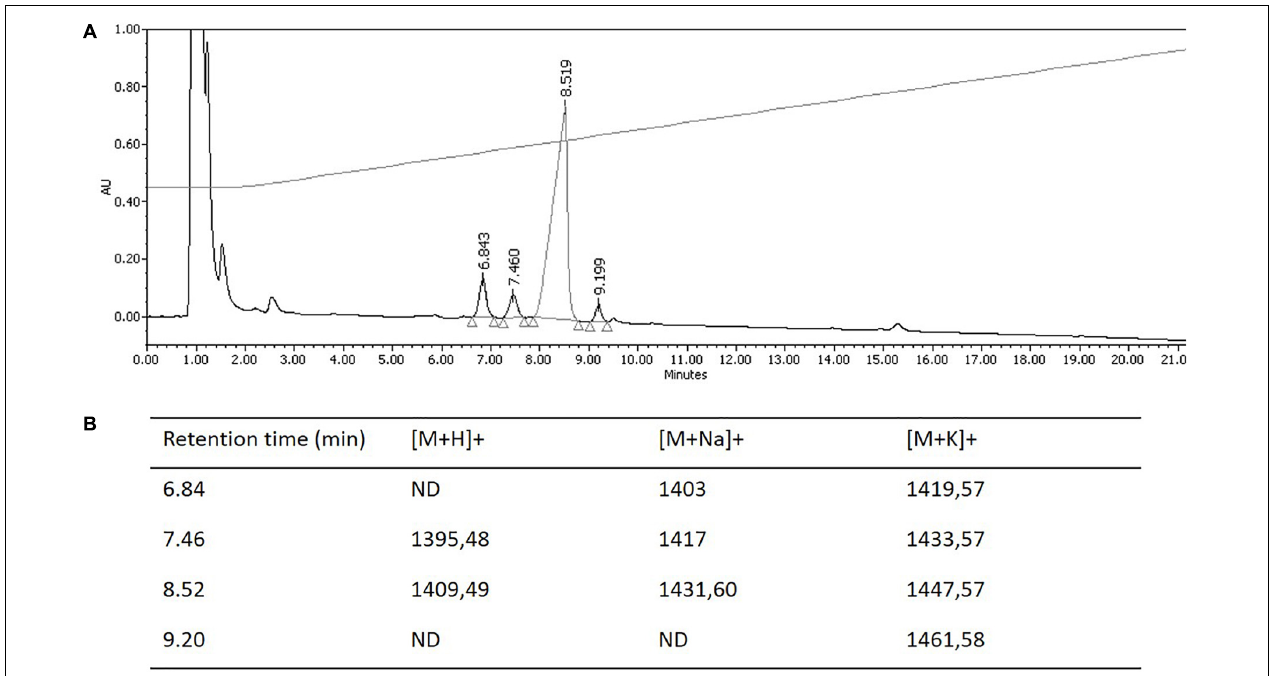
FIGURE 3 | Purification and mass spectrometry analysis of biosurfactants isoforms produced by Pseudomonas sp. UCMA 17988. (A) Reverse-phase HPLC. Elution was carried out using H2O/ACN/formic acid 0.1% (v/v) solvent system and monitored at 220 nm. (B) Pseudo-molecular ions detected by MALDI-TOF analysis. ND, not detected.